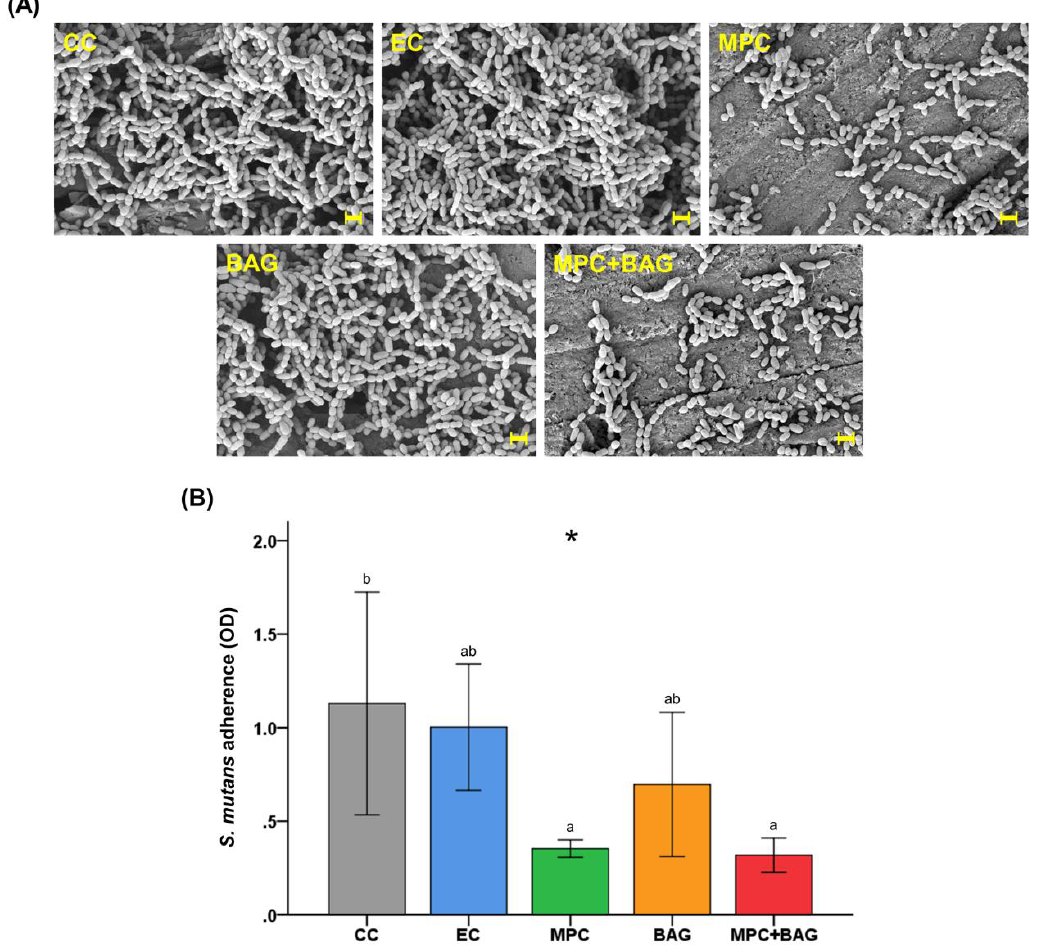
Figure 4. Representative scanning electron images of S. mutans attached to the surfaces of the groups at a magnification of 10,000 × ( A ). The scale bar is 1 µ m. Water-soluble tetrazolium counts derived from S. mutans attached on the surfaces of each group ( B ). The groups are: Commercial control (CC), experimental control of 50 wt% resin matrix + 50 wt% glass filler (EC), 48.5 wt% resin matrix + 48.5 wt% glass filler + 3 wt% MPC (MPC), 50 wt% resin matrix + 37.5 wt% glass filler + 12.5 wt% BAG (BAG), and 48.5 wt% resin matrix + 36.38 wt% glass filler + 12.12 wt% BAG + 3 wt% MPC (MPC + BAG). The different letters above the bars indicate significant differences. * p < 0.05 for the comparison between all groups.